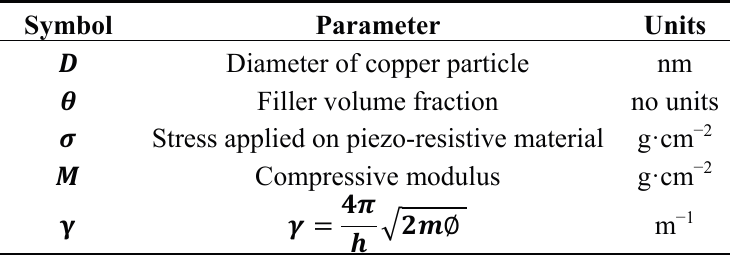
Table 1. Parameters and their units used in Equation